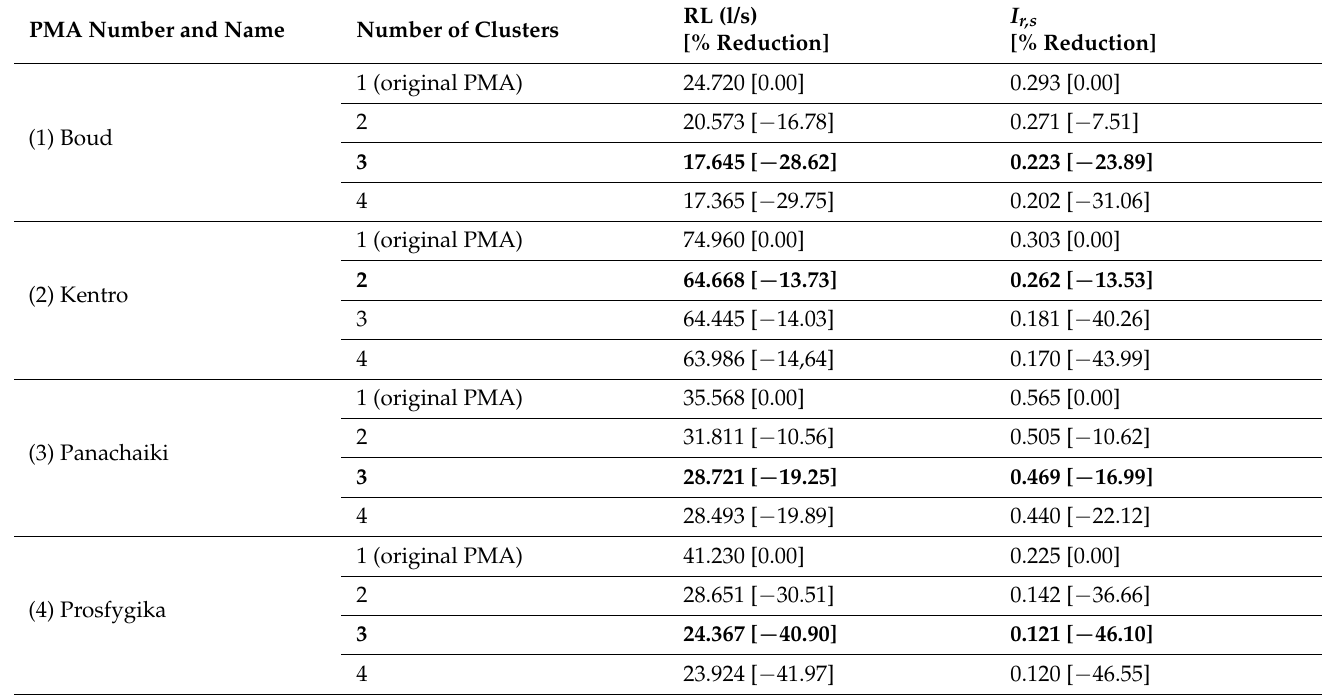
Table 4. Total number of clusters (one cluster corresponds to the original PMA configuration prior to partitioning), calculated flow rates of real losses (RL), and resilience index estimates for the four PMAs of the WDN of the city of Patras. Values in square brackets indicate percentage reduction relative to the original PMA configuration. Numbers indicate PMA locations in Figure